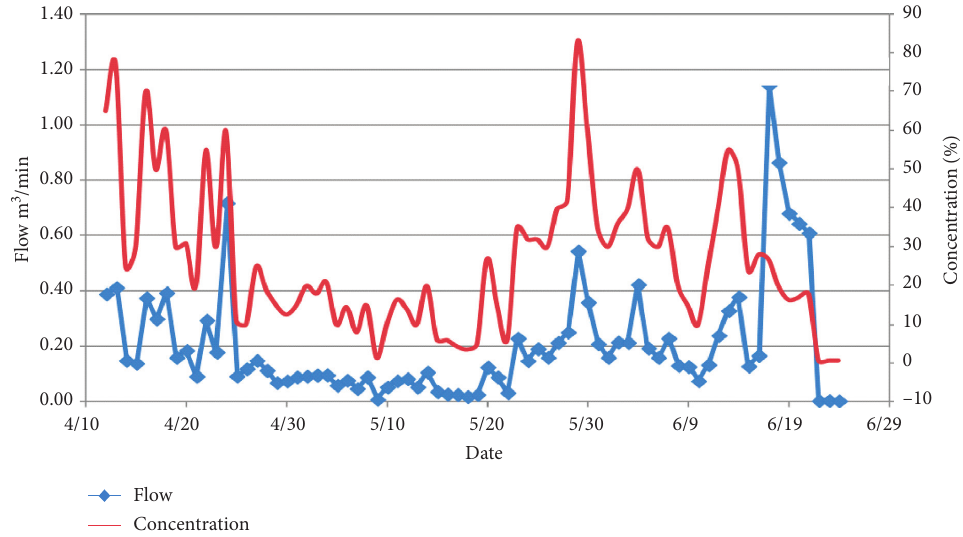
Figure 7: Extraction concentration and pure flow curve of the roof borehole 1-1.